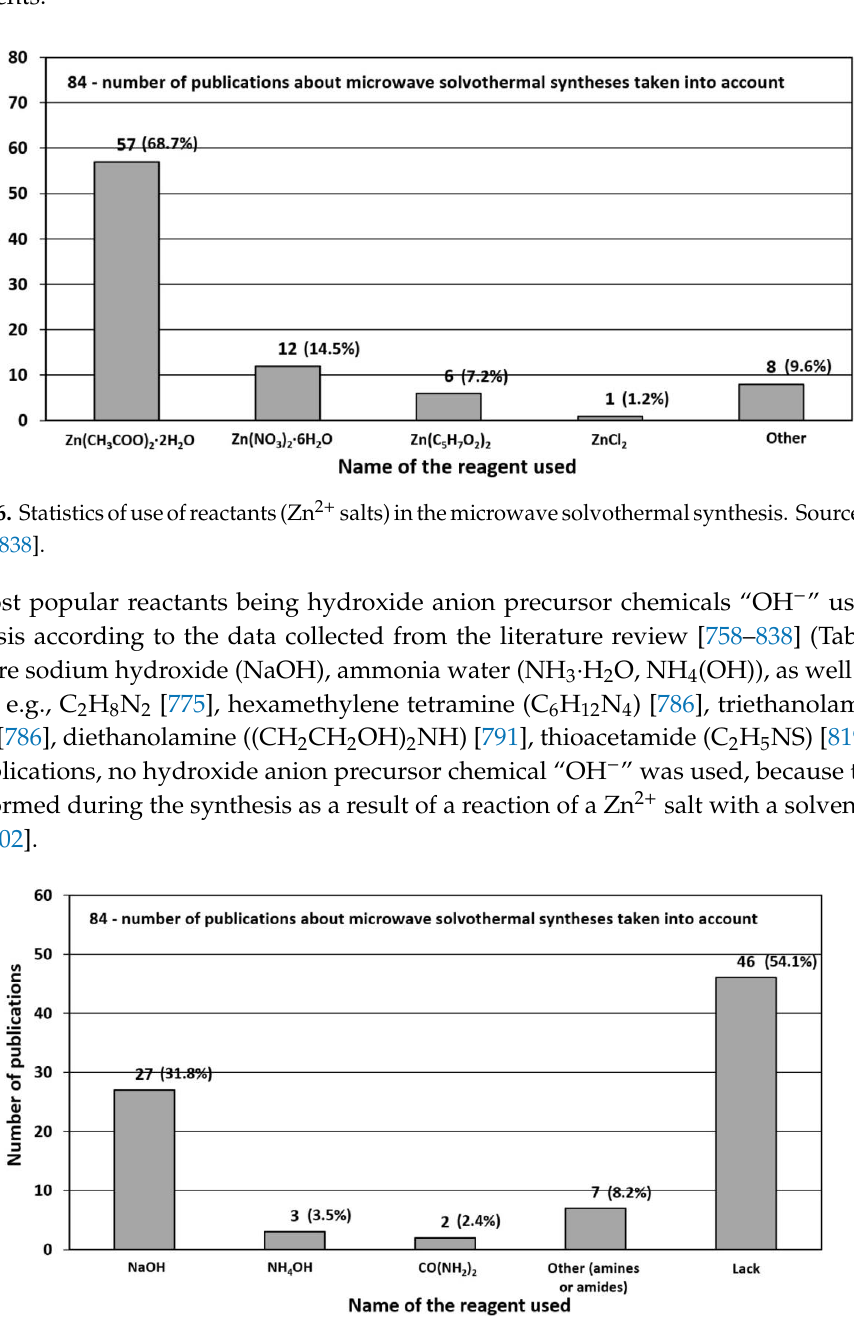
Figure 37. Statistics of use of reactants (OH − ) in the microwave solvothermal synthesis. Source: